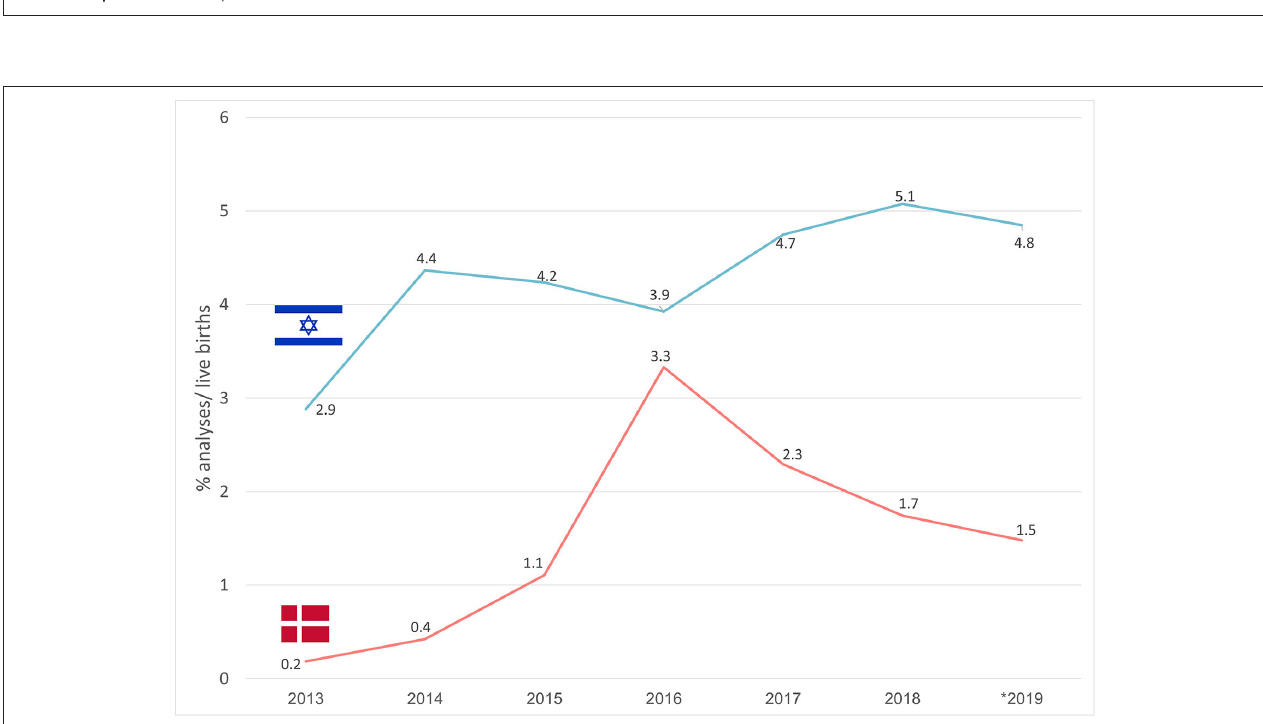
FIGURE 3 | Trends in the uptake of NIPS in % of live births in Denmark and Israel.